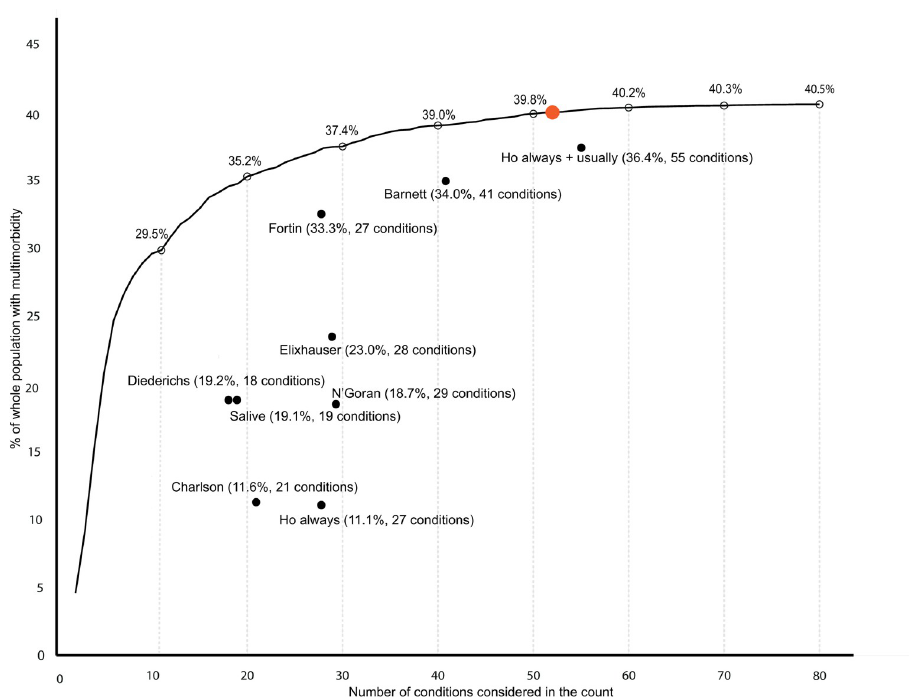
Fig 1. Multimorbidity prevalence according to number of conditions, the ceiling effect where adding additional conditions had little impact on prevalence, and selection of conditions using existing condition-lists. AU : AbbreviationlistshavebeencompiledforthoseusedinFigs 1 to 4 andTables 1 to 3 : Pleaseverifythatallentriesarecorrect : The black line represents multimorbidity prevalence calculated when considering different numbers of conditions in the count ranging from 2 to all 80 conditions, where conditions were added in order of most to least prevalent (e.g., at 2 conditions this is multimorbidity prevalence considering the most common 2 conditions). Percentage prevalence of multimorbidity when 10, 20, 30, 40, 50, 60, 70, and 80 conditions were considered is marked at empty black circles above the black line. The number of conditions at which RR was > 0.99 of multimorbidity prevalence of having the same multimorbidity prevalence when all 80 conditions were considered (ceiling effect) was reached is marked with an orange dot (at 52 conditions). Black dots represent multimorbidity prevalence when considering conditions included in existing condition-lists and are annotated with the condition-list name, prevalence, and number of conditions considered. RR, relative risk.